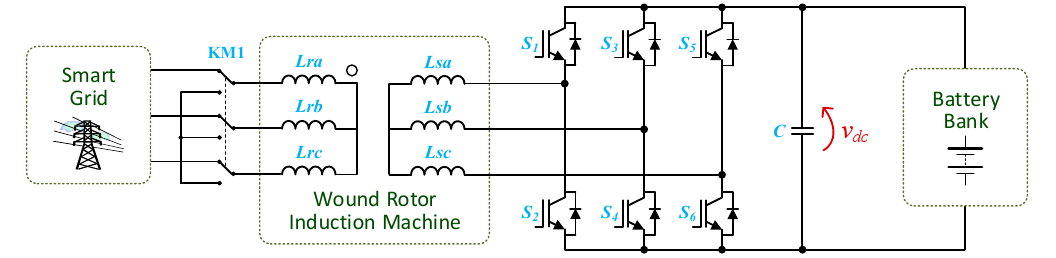
Figure 38. Unified system for traction and battery charging of an electric forklift.